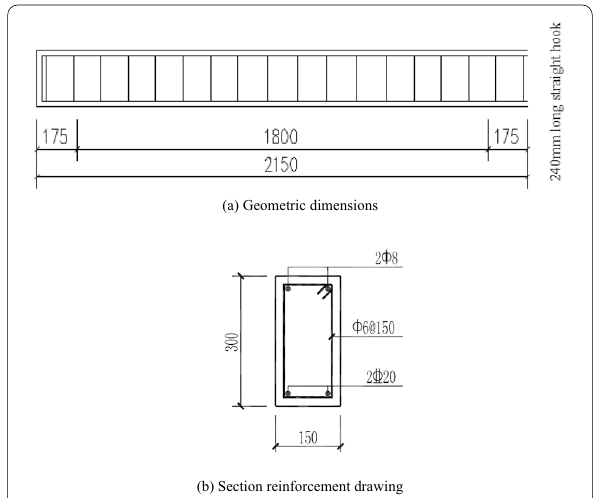
Fig. 1 Geometric dimensions and section reinforcement drawing of concrete beams under tests.